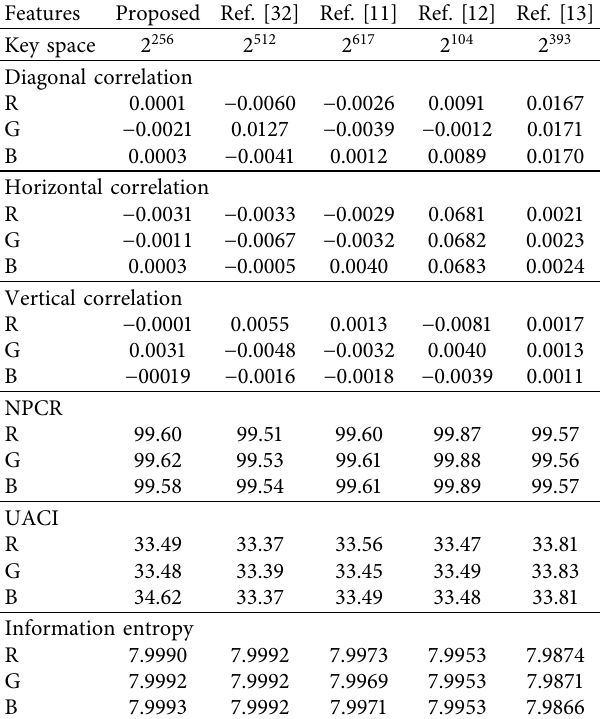
Table 10: Comparison of statistical results of the suggested scheme with existing